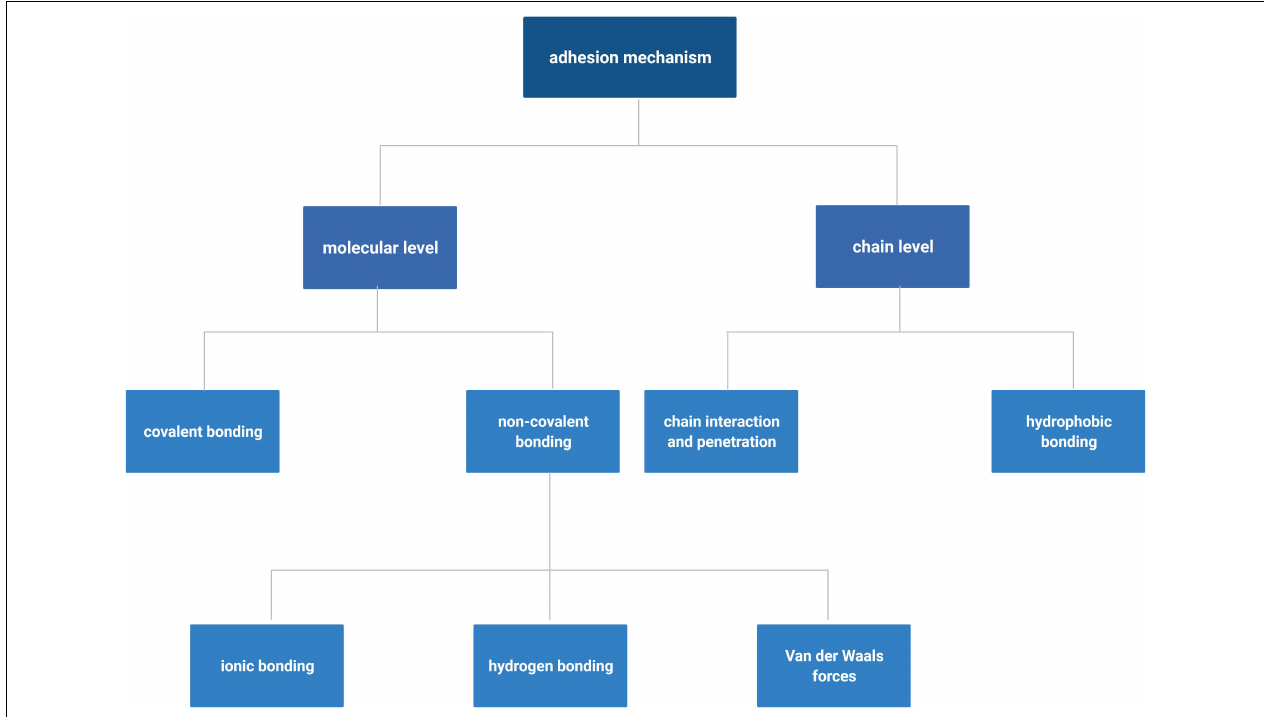
FIGURE 1 | Summary of different mechanisms of adhesion of tissue engineering scaffolds. Created with